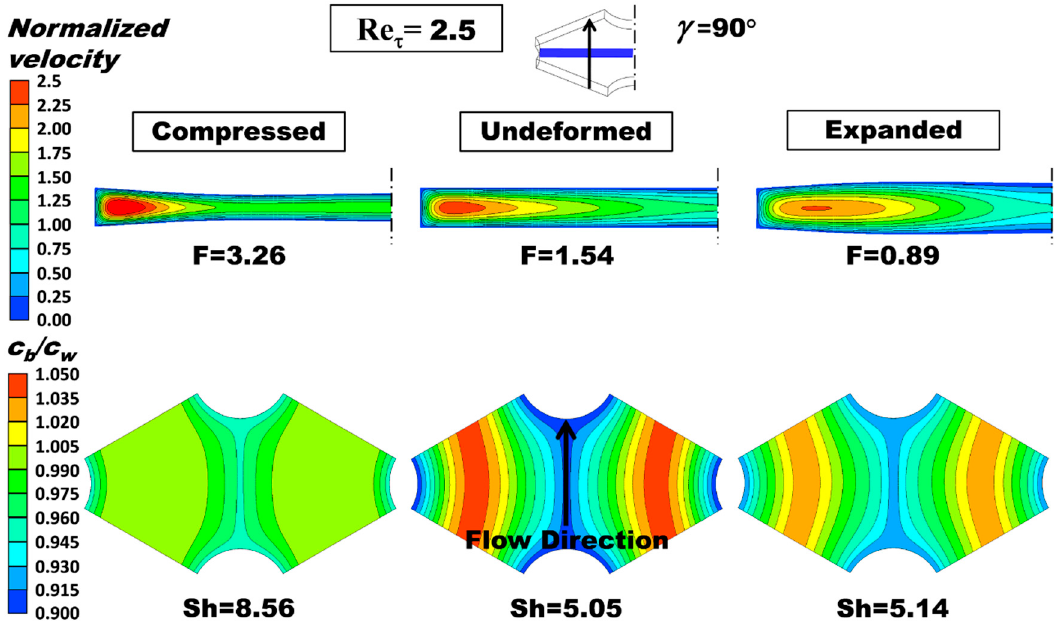
Figure 8. Influence of deformation on flow and mass transfer for P / H = 10, γ = 90 ◦ , and Re τ = 2.5. Left column: compressed (TMP = + 0.4 bar, Re = 2.4); middle column: undeformed (Re = 5.1); right column: expanded (TMP = − 0.4 bar, Re = 8.9). Top row: distribution of the streamwise velocity component in the central cross section of the channel (for symmetry reasons, only half map is shown); bottom row: distribution of the polarization coefficient on either of the walls. c b = 500 mol/m 3 , flux corresponding to a current density of 50 A/m 2 entering the fluid domain (dilute channel of RED or a concentrate channel of ED). The F ratio and Sherwood number are also reported.